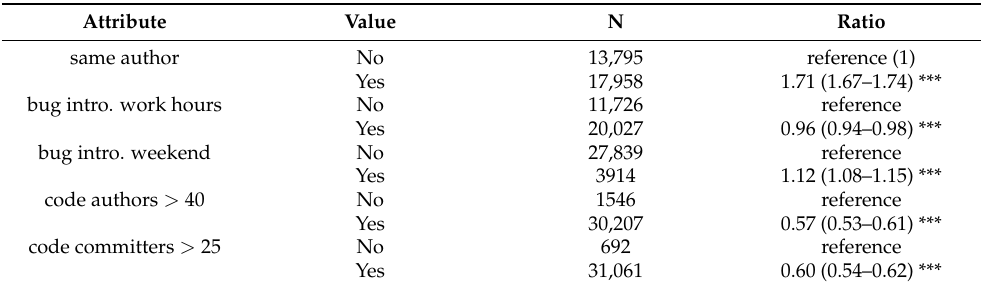
Table 4. Hazard Ratio (HR) of categorical attributes of projects with count and confidence intervals for